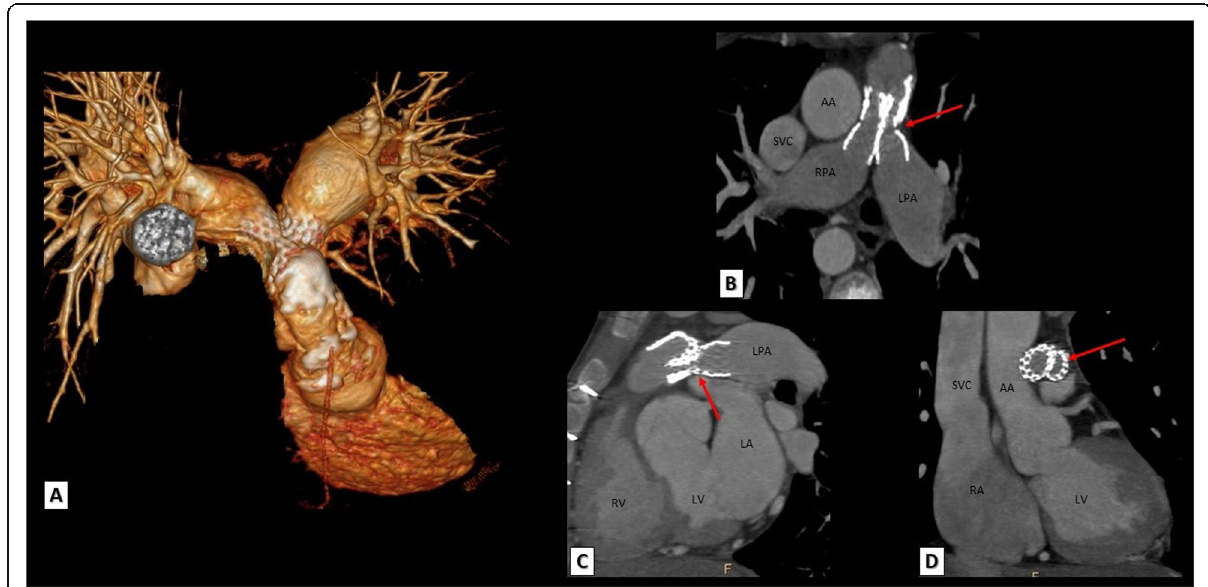
Fig. 12 A TOF patient with both right and left pulmonary arteries stenting. a 3D VRT, b reformatted axial, c reconstructed sagittal, and d reconstructed coronal images showing LPA stent fracture with significant narrowing of LPA ostium (red arrows). AA, ascending aorta; RPA, right pulmonary artery; LPA, left pulmonary artery; SVC, superior vena cava; LV, left ventricle; RV, right ventricle; LA, left atrium; RA, right atrium